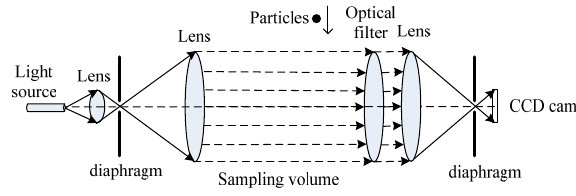
Figure 2. The schematic diagram of imaging. 2